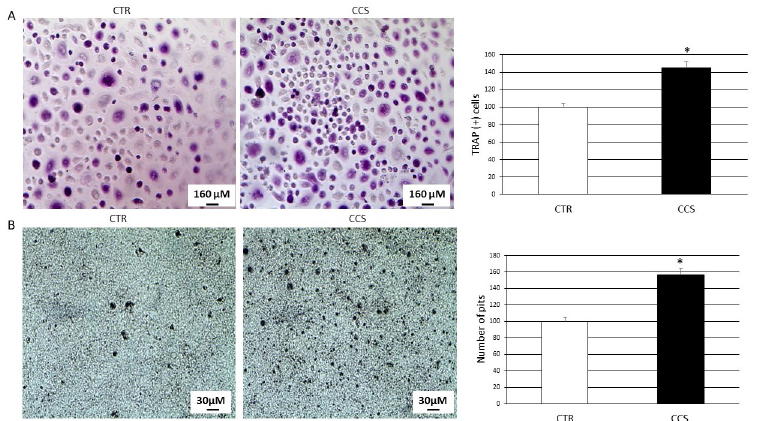
Fig 2. (A) TRAP assay on 5 CCS compared with OCs from 5 CTR. The most representative images are displayed (10x magnification). An AE2000 inverted microscope has been used to count TRAP (+) multinucleated (n � 3) OCs (stained purple) in at least three different wells for each individual sample. Histogram shows the percentage number of TRAP (+) cells respect to the total cell number for each sample as mean ± SD. (B) Bone resorption assay on 5 CCS compared with OCs from 5 CTR. The most representative images are displayed (10x magnification). An AE2000 inverted microscope has been used to count the pits (represented in the image as darker areas) on the plate in at least three different wells for each individual sample. Histogram shows the percentage number of pits as mean ± SD. For statistical analysis it has been used a t-test. � Indicates p � 0.05 compared to CTR.